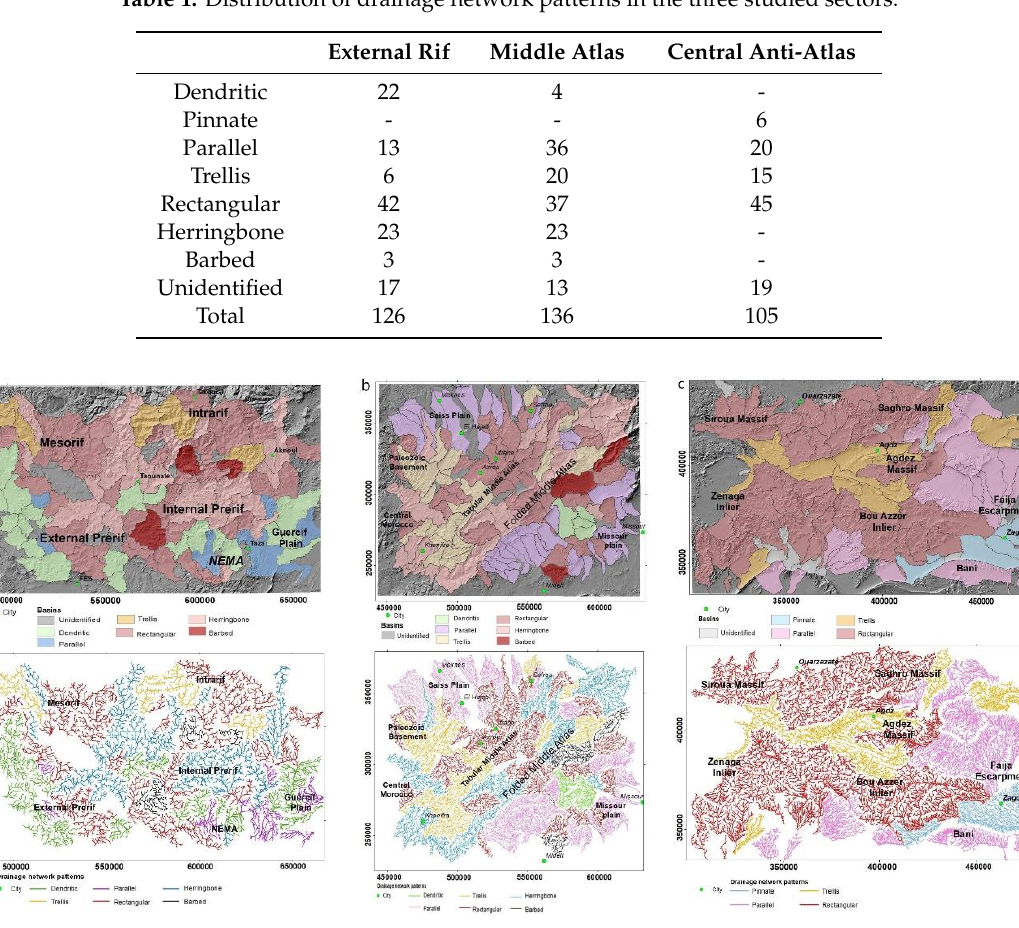
Figure 6. Spatial distribution of the different drainage network patterns in ( a ) The external Rif, ( b ) the Middle Atlas, and ( c ) the Central Anti-Atlas. Table 1. Distribution of drainage network patterns in the three studied sectors.